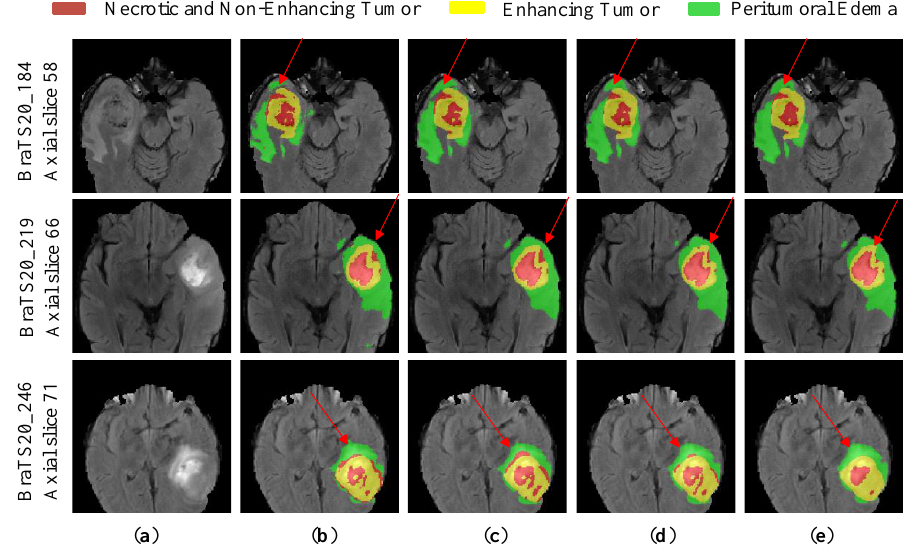
Figure 10. Segmentation results of brain tumor images by different networks. ( a ) is the modality of Flair, ( b ) stands for ground truth, ( c ) stands for MVKS-Net, ( d ) stands for HDC-Net, ( e ) stands for DMF-Net. The yellow area is the enhancing tumor area. The red area is the necrotic and non- enhancing area. The green area is the peritumoral edema